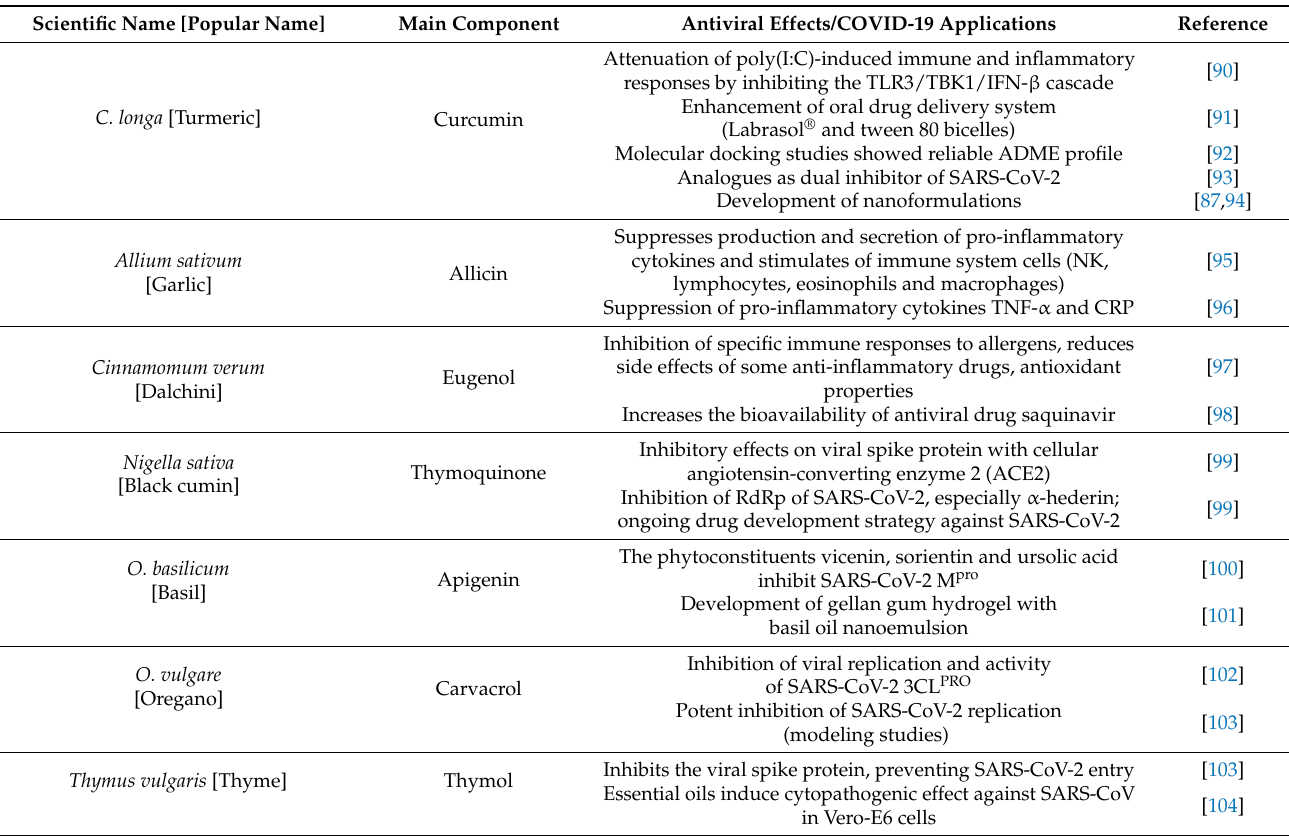
Table 3. Plant spices and condiments and their antiviral